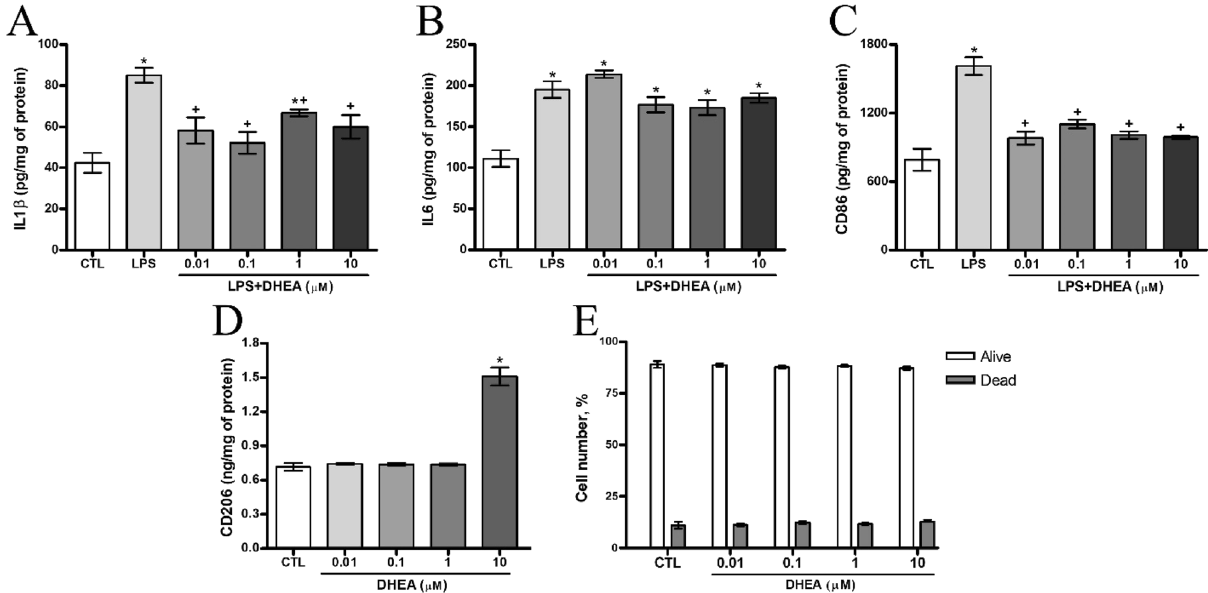
Figure 5. Suppression of pro-inflammatory responses by DHEA in LPS-activated SIM-A9 microglial cells. Level of ( A ) IL-1β, ( B ) IL6, ( C ) CD86, ( D ) CD206 expression in the microglial cells. ( E ) A histogram demonstrating the absence of DHEA effect on apoptosis of microglia cells. *Significant differences between “CTL” and “LPS”, “LPS + DHEA” at similar observation points. + Significant differences between “LPS” and “LPS + DHEA” at similar observation points. Data are the mean ± SEM, n = 9 (number of analyzed samples), P < 0.05, (one-way ANOVA, post-test Tukey). Images were prepared with using GIMP 2.10.22 software (http://